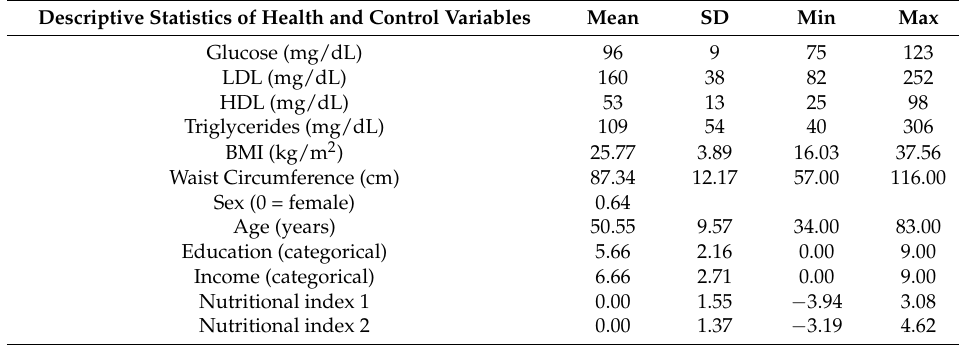
Table 2. Arithmetical mean, standard deviation, minimum and maximum values of the health and control co-variables ( n = 131).